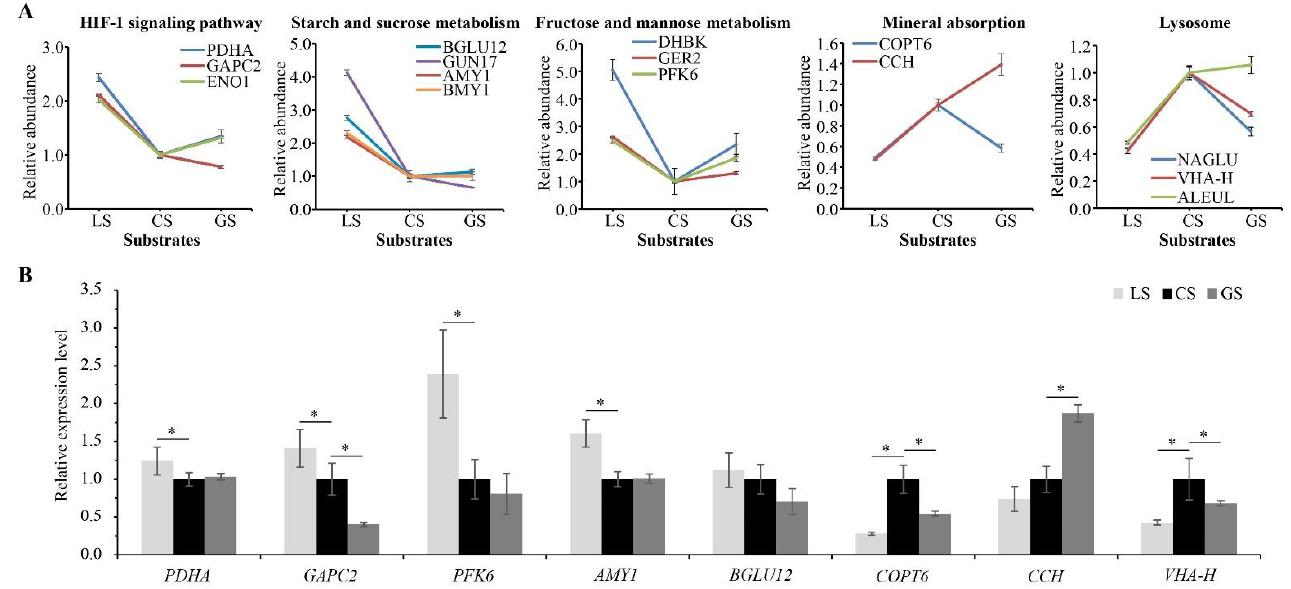
Figure 6. Effects of substrate containing gravel on proteins related to air permeability, glucose metabolism, and heat conduction. PFK6 shown in fructose and mannose metabolism was also annotated to starch and sucrose metabolism: ( A ) related protein abundance levels; and ( B ) RT-qPCR analysis of eight related proteins. Error bars represent the SD of the quantitative mean value of proteomic and RT-qPCR results. * represents significant difference with the p value < 0.05.